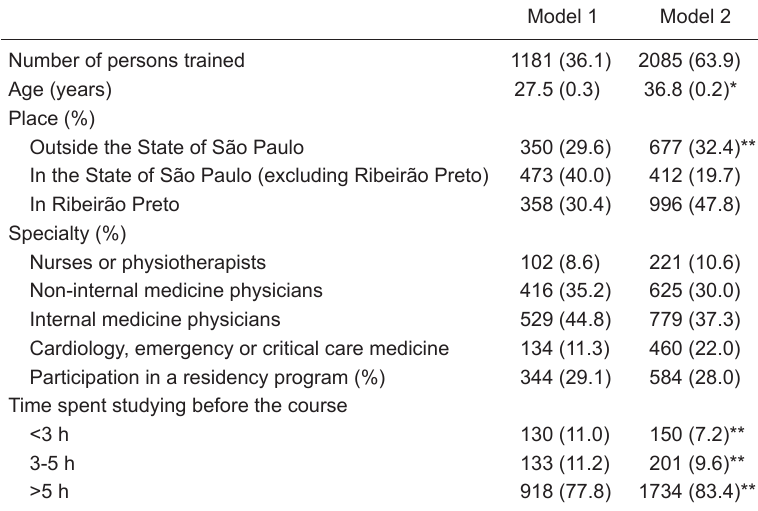
Table 1. Students’ characteristics according to course model.